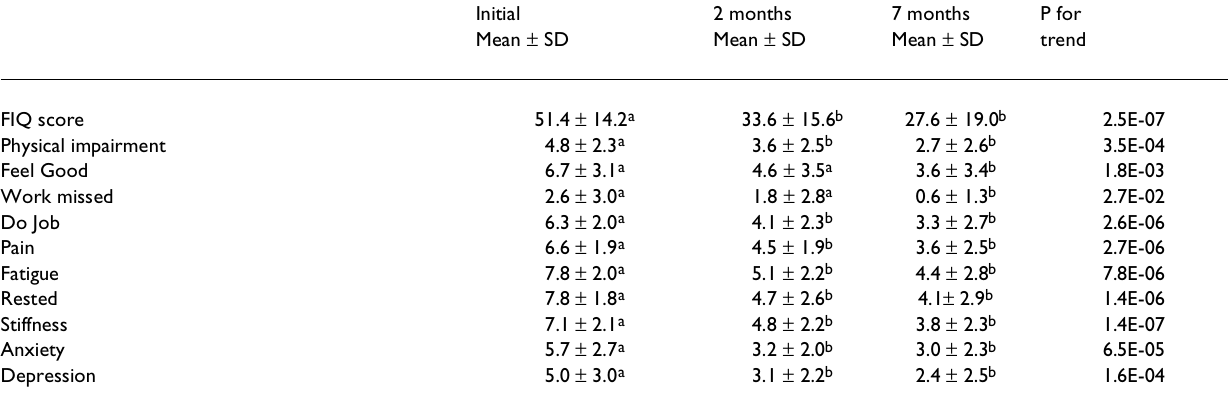
Table 3: Fibromyalgia Impact Questionnaire Results. N = 20 at each time